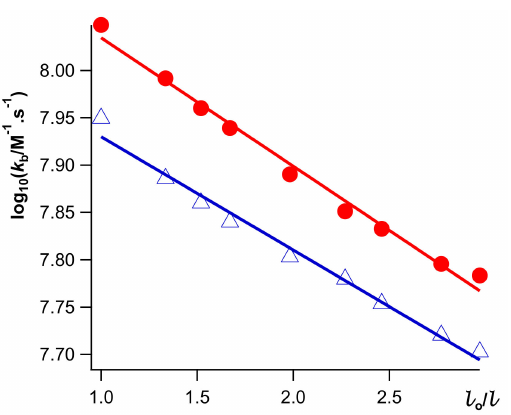
Figure 5. Dependencies of log 10 k b upon stretching of films in the Earth’s MF (circles) and in MF B = 0.2 T (triangles). ζ o was different for the studied E films. Adapted from Ref.